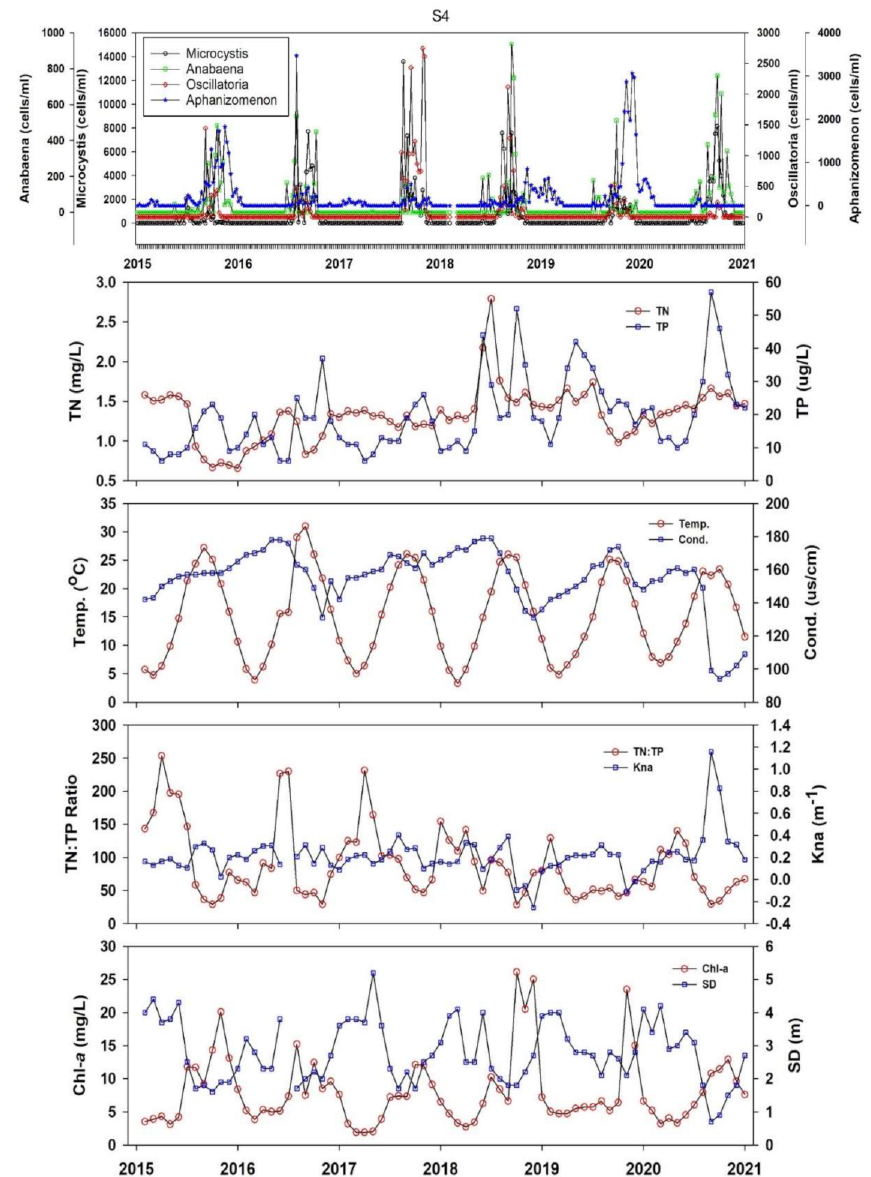
Figure 11. Relationship between the algal blooms of four blue-green algae species, nutrients, ambient ratios, water temperature, and algal CHL-a during